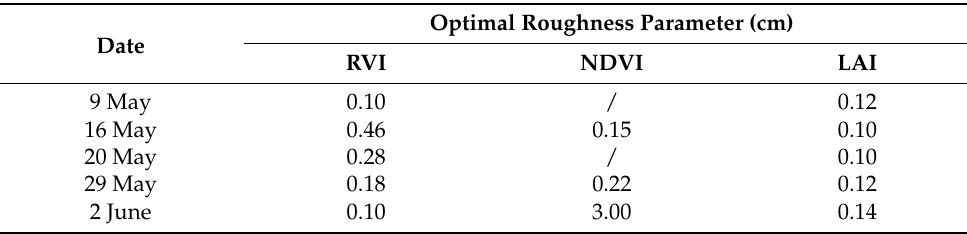
Table 4. The value of optimal roughness parameter when different vegetation parameters were used as vegetation description parameters